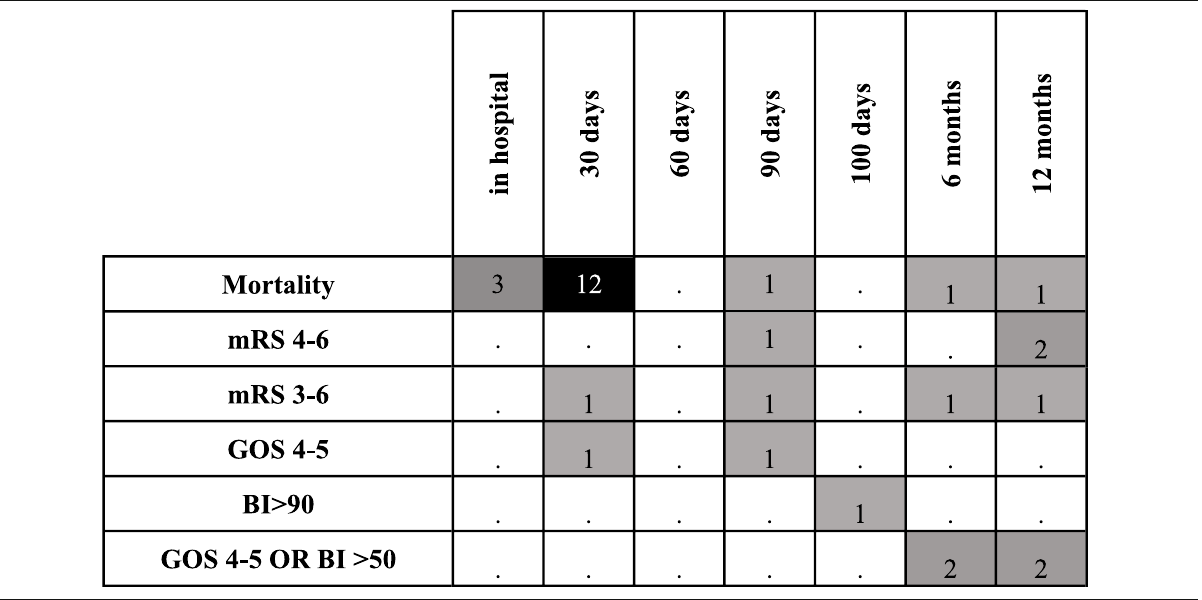
Table 2 Type and timing of outcome assessment in current ICH prediction